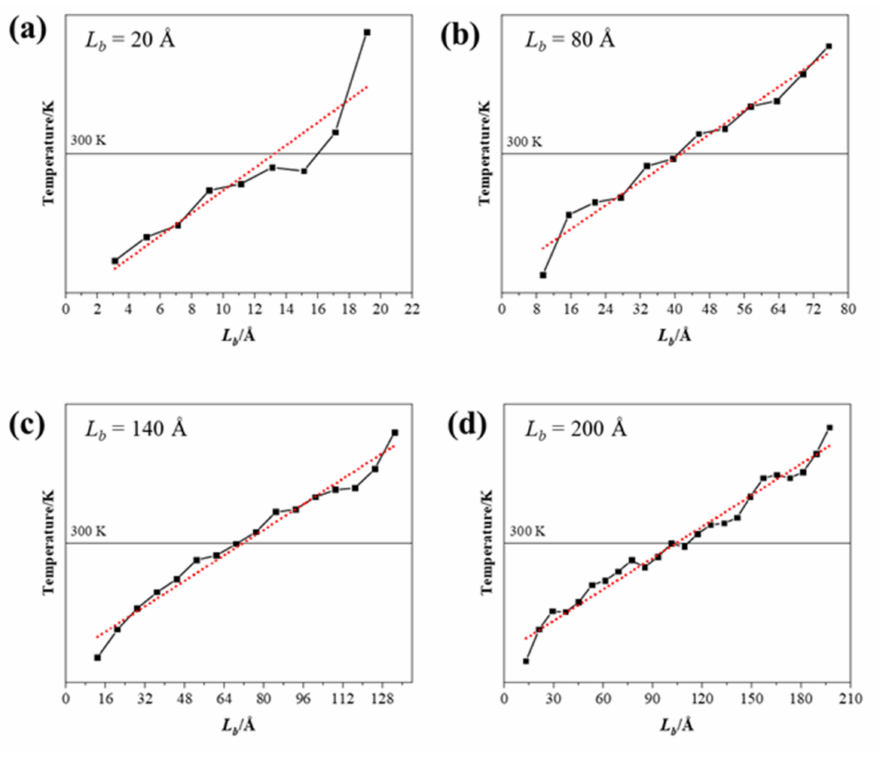
Figure 6. The temperature distribution and temperature gradient at system size of ( a ) 20 Å, ( b ) 40 Å,